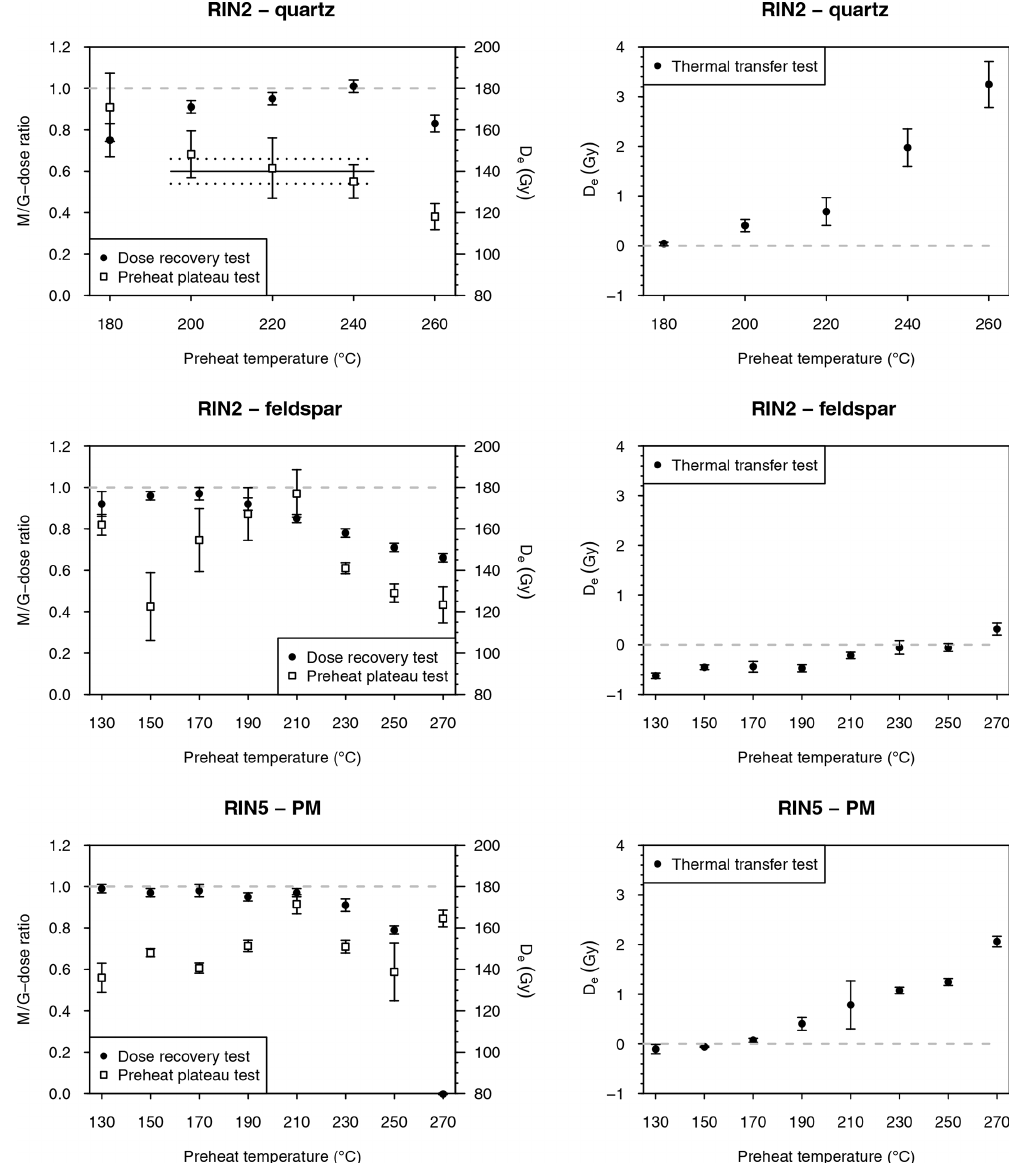
Figure 3. Preheat plateau, dose recovery and thermal transfer test results for Q and F of RIN2 and f Q and PM of RIN5. Presented are CAM D e values with 1 σ uncertainties for 3 (F, PM) or 5 (Q, f Q) aliquots per preheat temperature. Dose recovery results are presented as measured-to-given dose ratios (M / G